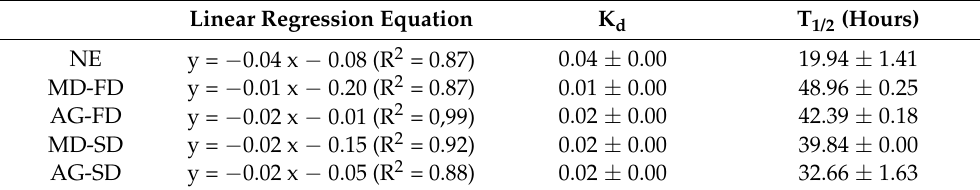
Table 5. Kinetic values for the red dye extract non-encapsulated (NE) and extracts encapsulated with maltodextrin (MD) and Arabic gum (AG) obtained by freeze-drying (FD) and by spray-drying (SD) (mean ± SD). Linear regression equation, K values, regression coefficient (r 2 ), degradation rates values (K d ) and half-life time (t 1/2 ) (mean ± SD), at 80 ◦ C. Linear Regression Equation K d T 1/2